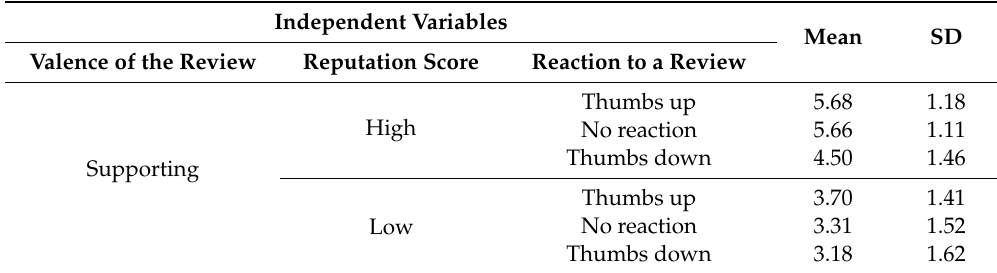
Table 2. Mean values of level of